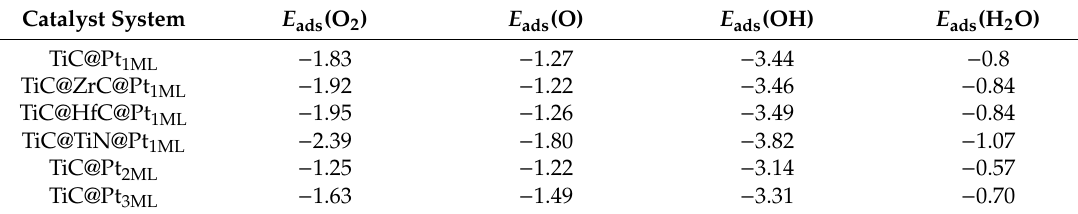
Table 1. The corresponding adsorption energy E ads of possible ORR